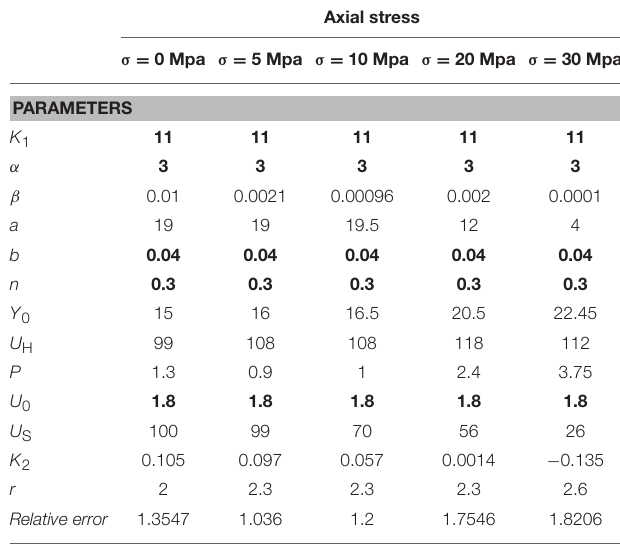
TABLE 3 | Pattern search method: identified parameters.